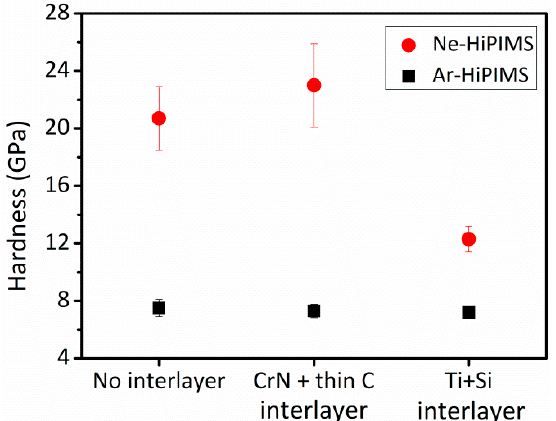
Figure 6. The hardness of the Ar- and Ne-HiPIMS DLC films deposited at the substrate bias of − 200 V on a Si substrate as well as on the Ti + Si and Cr + CrN interlayers.